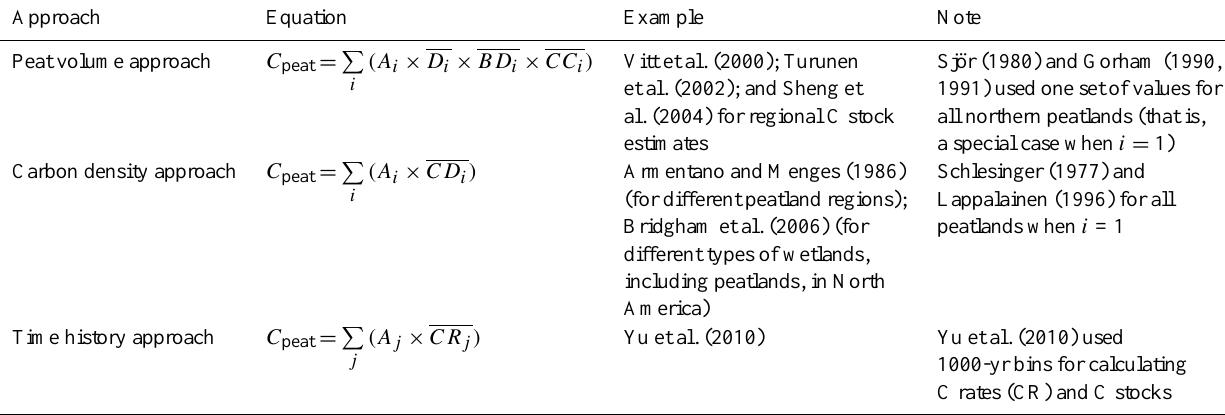
Table 1. General equations of different approaches for estimating peatland carbon stocks.